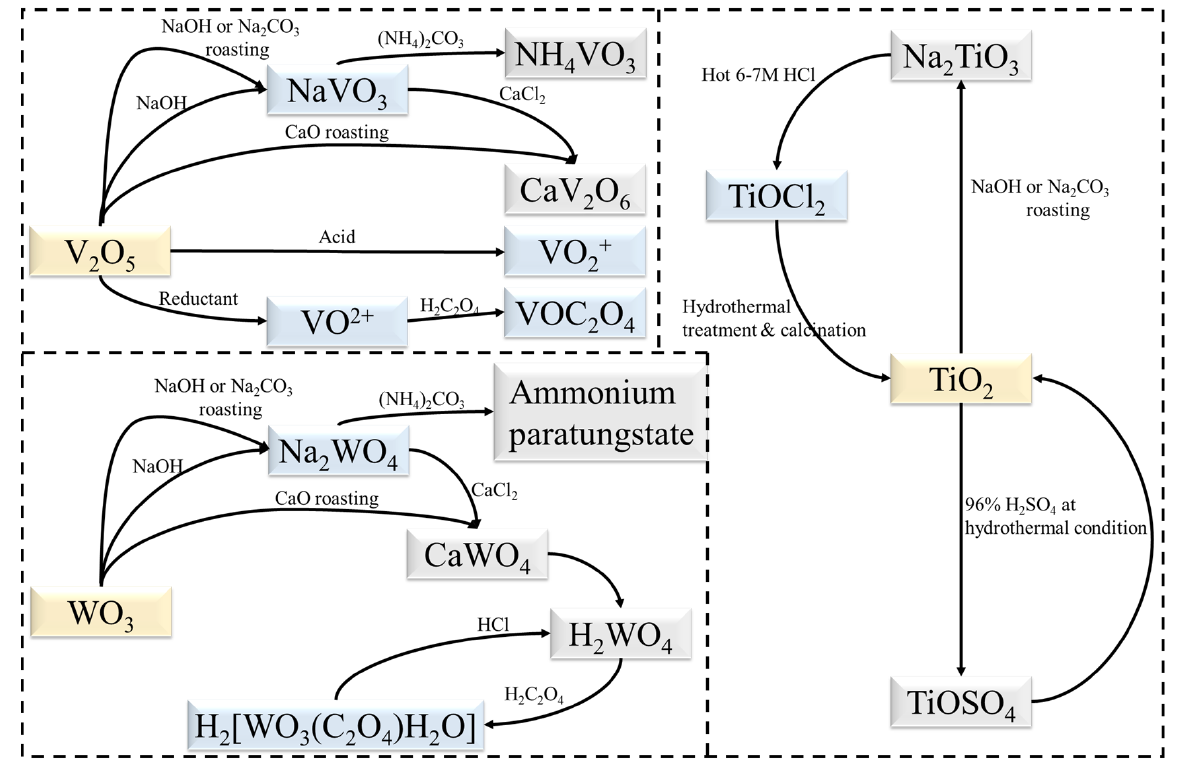
Figure 7. Transformation relationships of substances during extraction.